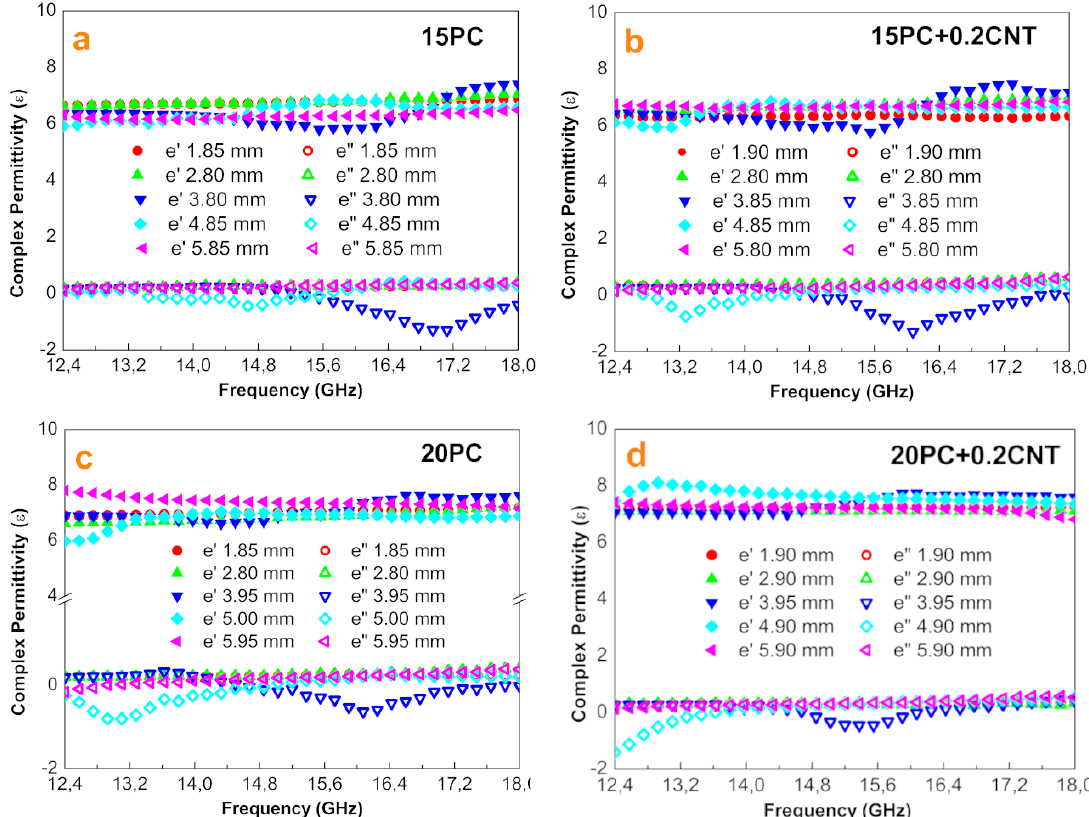
Figure 2. Complex permittivity: (a)15PC; (b) 15PC+0.2CNT; (c) 20PC; (d)